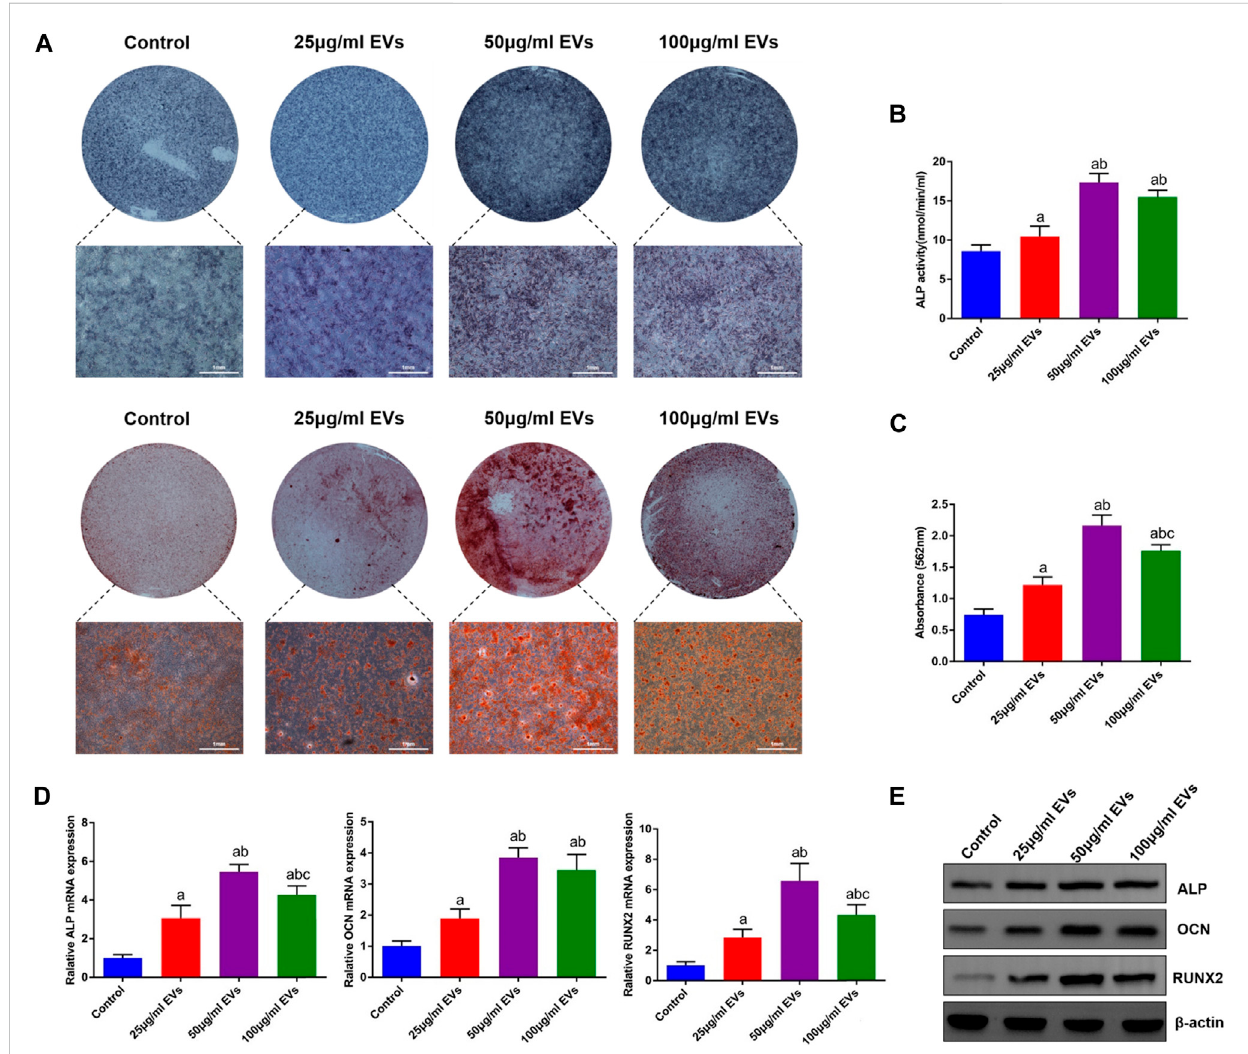
FIGURE 2 Effects of EVs on the osteogenic differentiation of rBMSCs (A) The observation of ALP and alizarin red staining (B) Quanti fi cation of ALP activity (C) Quanti fi cation of alizarin red staining (D) The expression of osteogenic genes (ALP, OCN and RUNX2) (E) The expression of osteogenic proteins